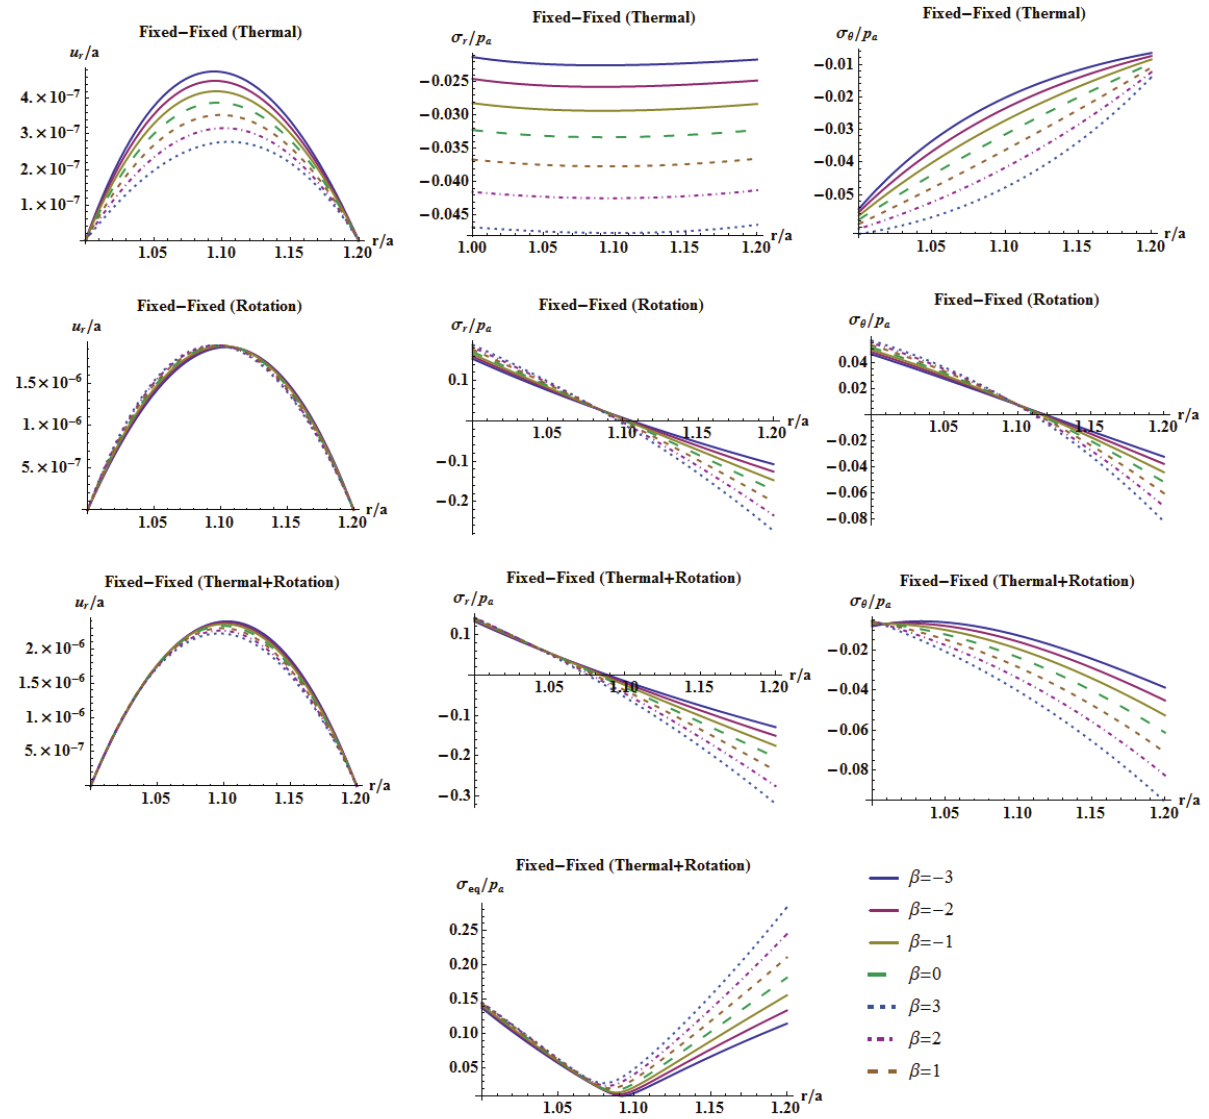
Figure 3. Variation of the dimensionless elastic fields with the inhomogeneity index under individual and combined loads for fixed-fixed boundary conditions.